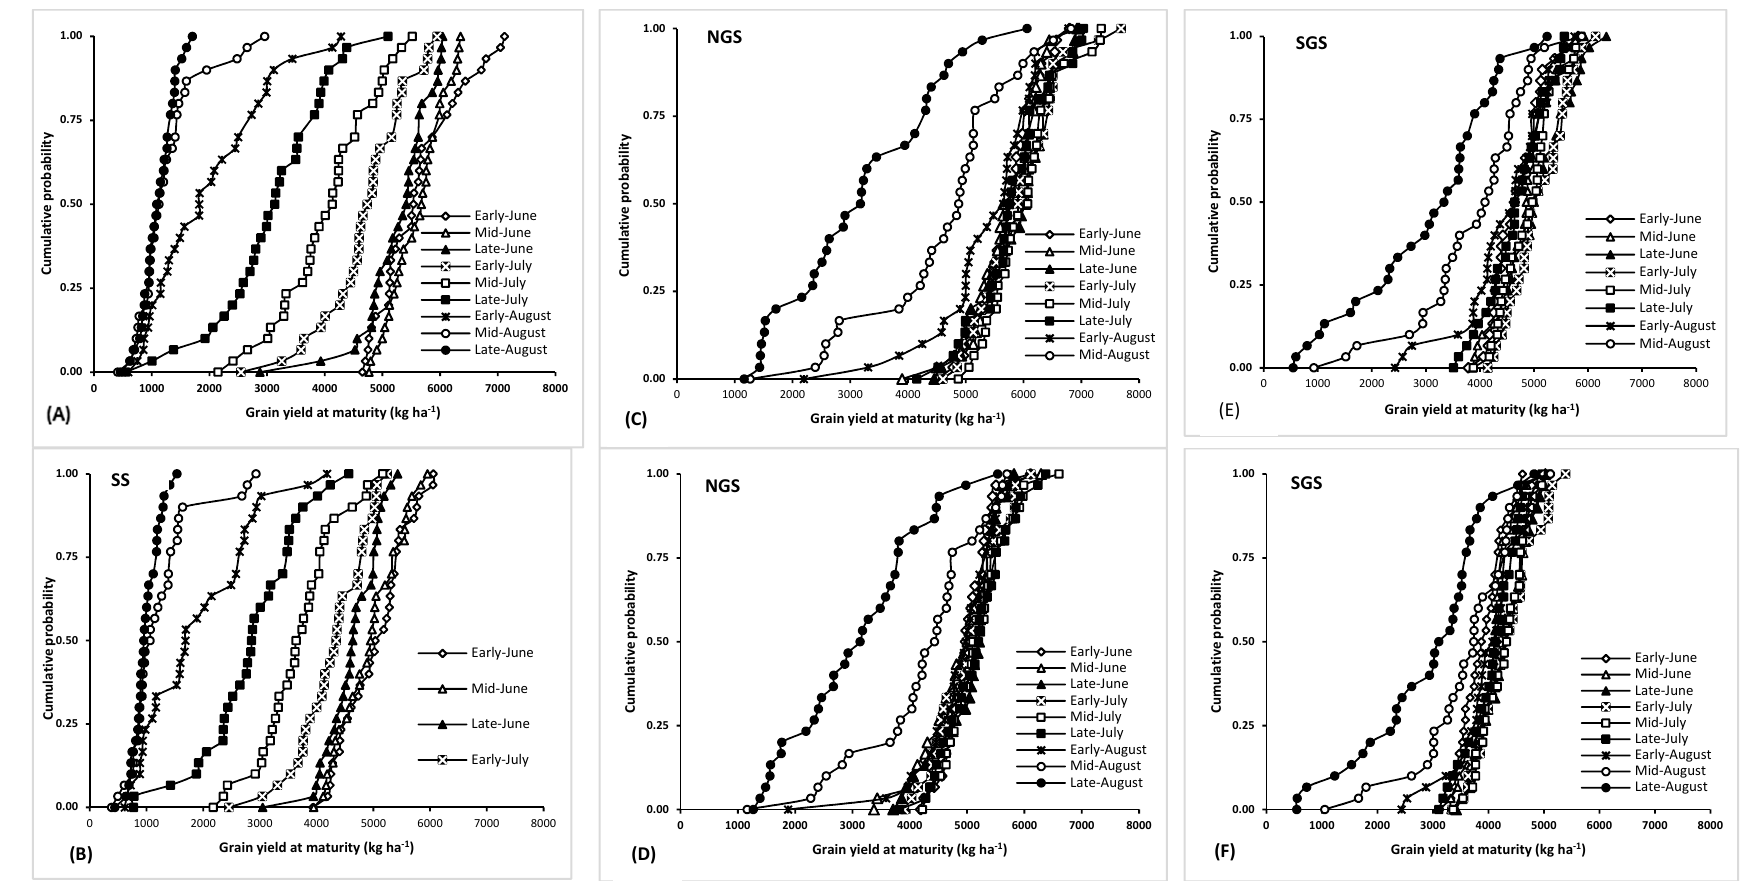
Figure 6. Cumulative function plots for simulated grain yields of SAMMAZ-15 ( A ) and SAMMAZ-16 ( B ) in SS; SAMMAZ 15 ( C ) and SAMMAZ-16 ( D ) in NGS; SAMMAZ-15 ( E ) and SAMMAZ-16 ( F ) in SGS over a 30-year (1985–2014) period.